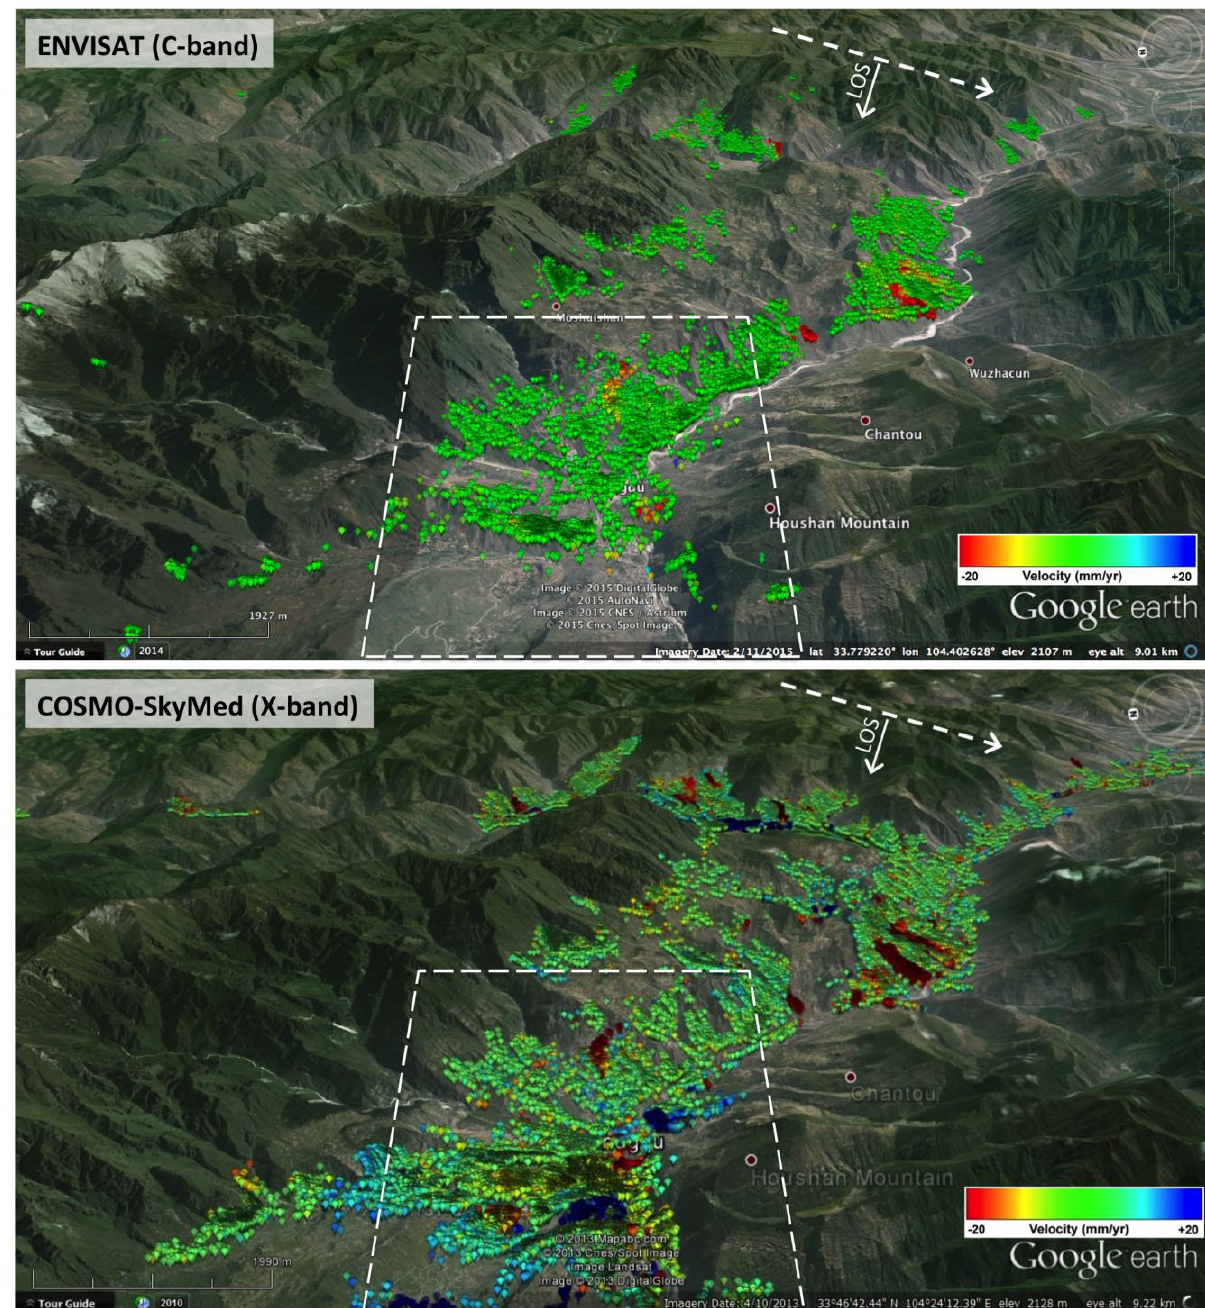
Figure 1. Regional scale (~1700 km 2 ) overviews of the distribution and average line of sight (LOS) velocity of radar targets (PS) in Southern Gansu Mountains, China. Velocity values are saturated to ±20 mm/year. Yellowish-reddish and bluish dots represent radar targets moving, respectively, away from and toward the satellite sensor. White dashed line polygons indicate the areas shown in Figure 2. Background images are from Google Earth TM . (Upper) MTI results obtained from ENVISAT ASAR data. (Lower) MTI results obtained from CSK